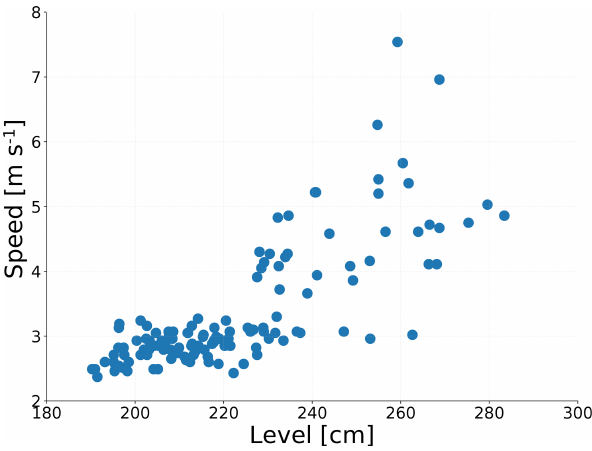
Figure A1. Scatter plot of water level (depth) (cm) and surface speed (ms − 1 ) for Doña María basin, located in the Aburrá Valley (basin outlet coordinates: 75.651 ◦ W, 6.190 ◦ N). The basin slope is 34.09%, the area 72.84km 2 , and the maximum (minimum) height 2835ma.s.l.